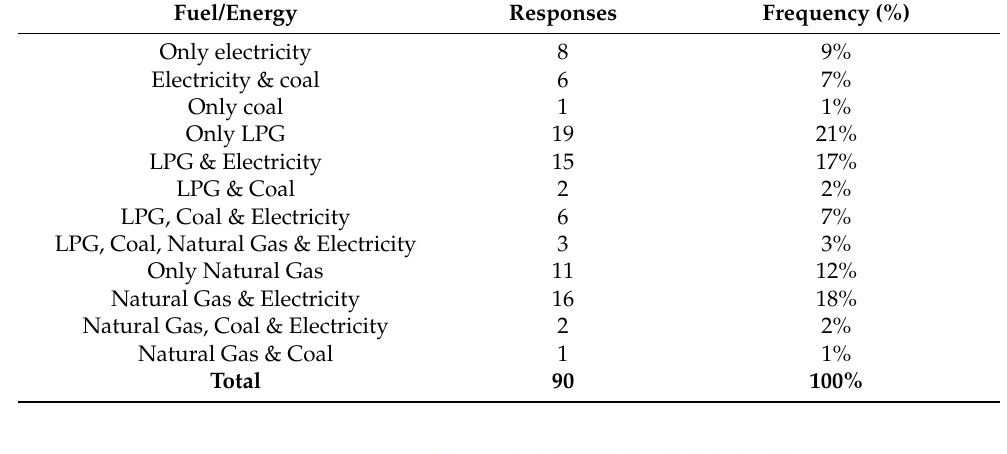
Table 3. Responses received to the question about the type of fuel and energy used for the cooking demands of the restaurants.